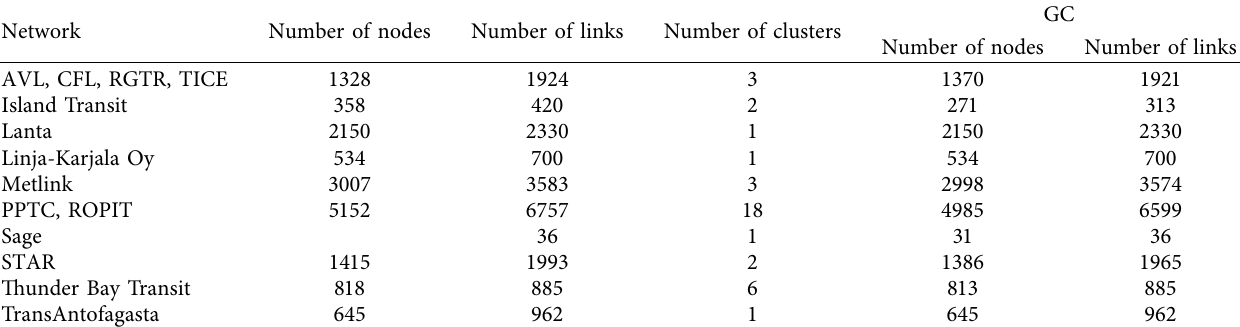
Table 2: Number of nodes, links, clusters, and characteristics of the GC in G ′ for all analyzed networks.